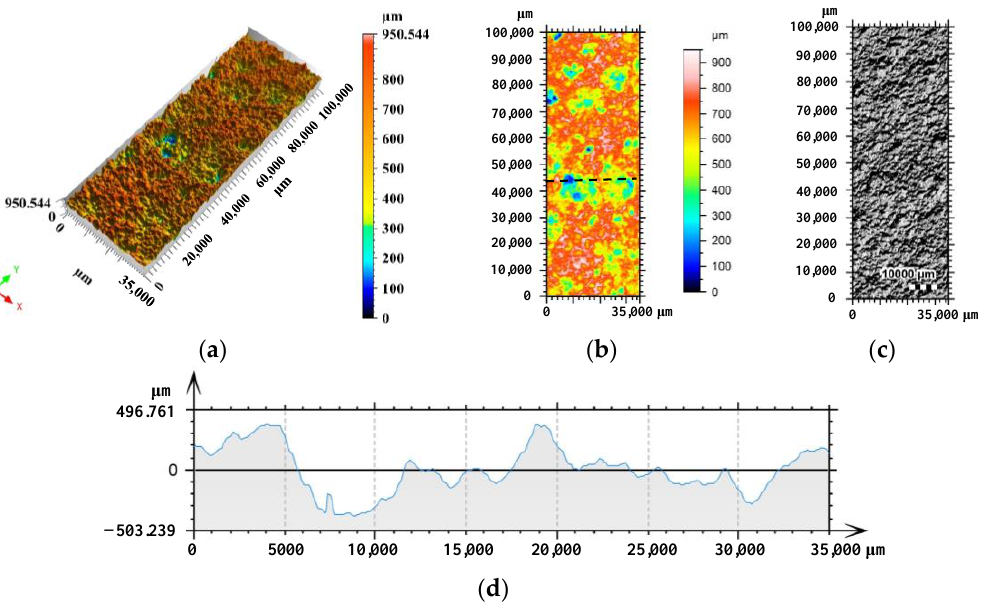
Figure 2. Three-dimensional morphology scanning results for front side of C6: ( a ) 3D view of the surface, ( b ) pseudo color view of the surface, ( c ) photo copy, and ( d ) profile curve.